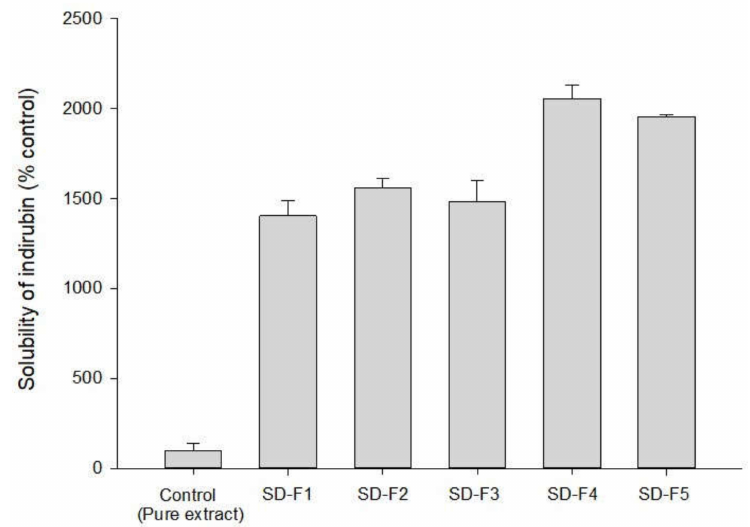
Figure 3. The effects of drug–polymer ratios on the aqueous solubility of indirubin in SD formulations of MT-102 (mean ± s.d., n = 3).